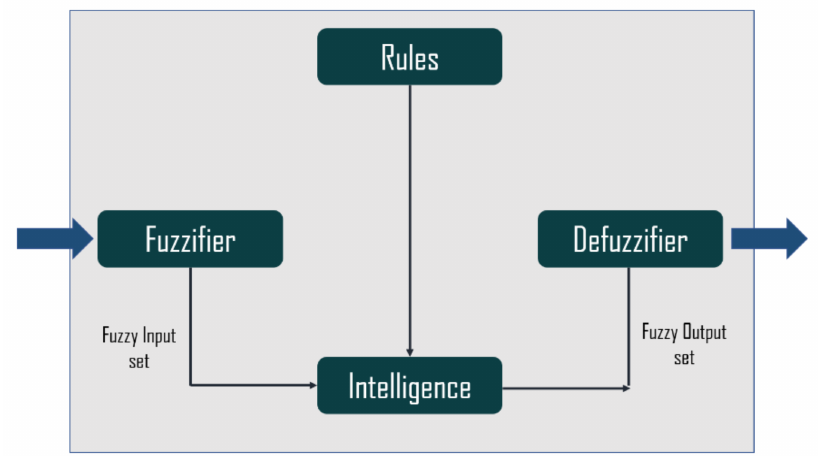
Figure 2. Fuzzy Logic Process. Source: https://www.edureka.co/blog/fuzzy-logic-ai.(accessed on 10 July